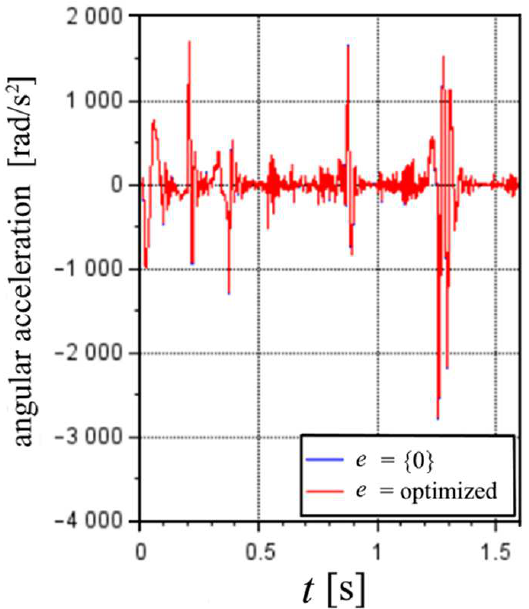
Figure 7. Nozzle acceleration in the inertial frame coordinates, considering timized values with initial guess values of zero in the ( a ) x -direction and ( b ) y -direction. To conclude the analysis, Figure 8 compares the rotational acceleration of the nozzle. The estimated angular acceleration results suffer from high fluctuations.